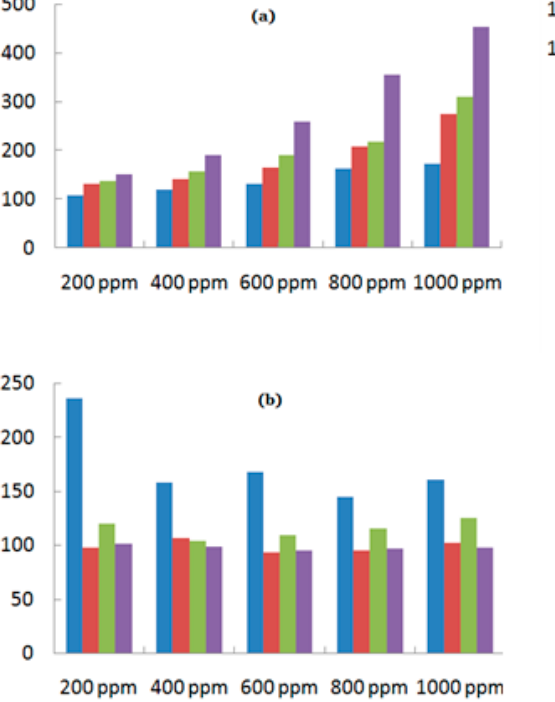
Figure 18. ( a ) Response, ( b ) response time, and ( c ) recovery time of different samples toward acetone at 300 ℃ .